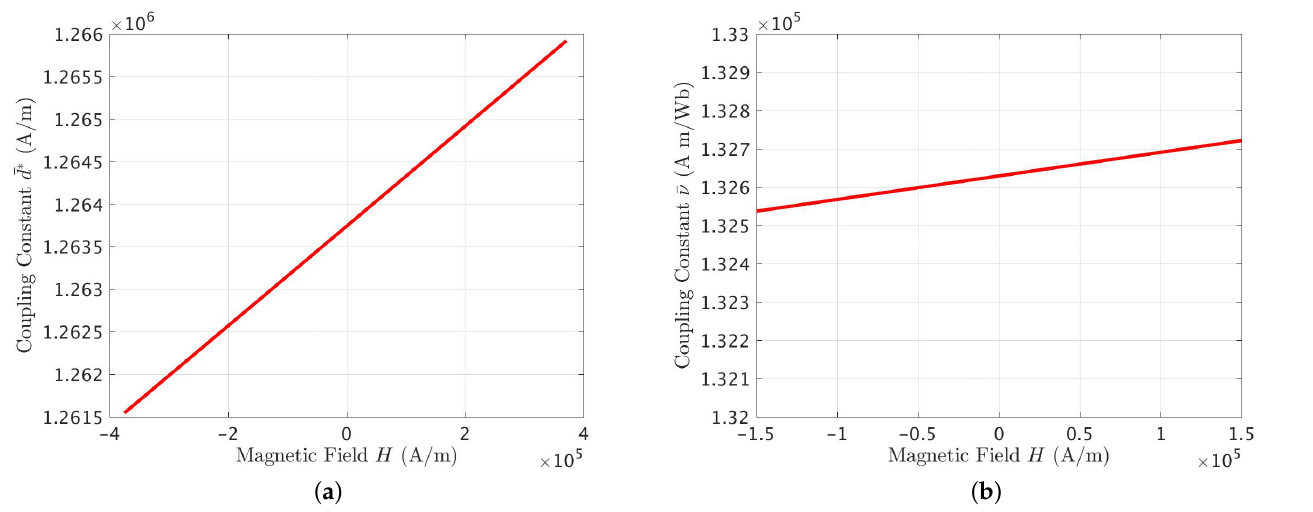
Figure 4. Effective coupling constant between strain and induced magnetic field, and the effective magnetic flux–density–magnetic field coupling